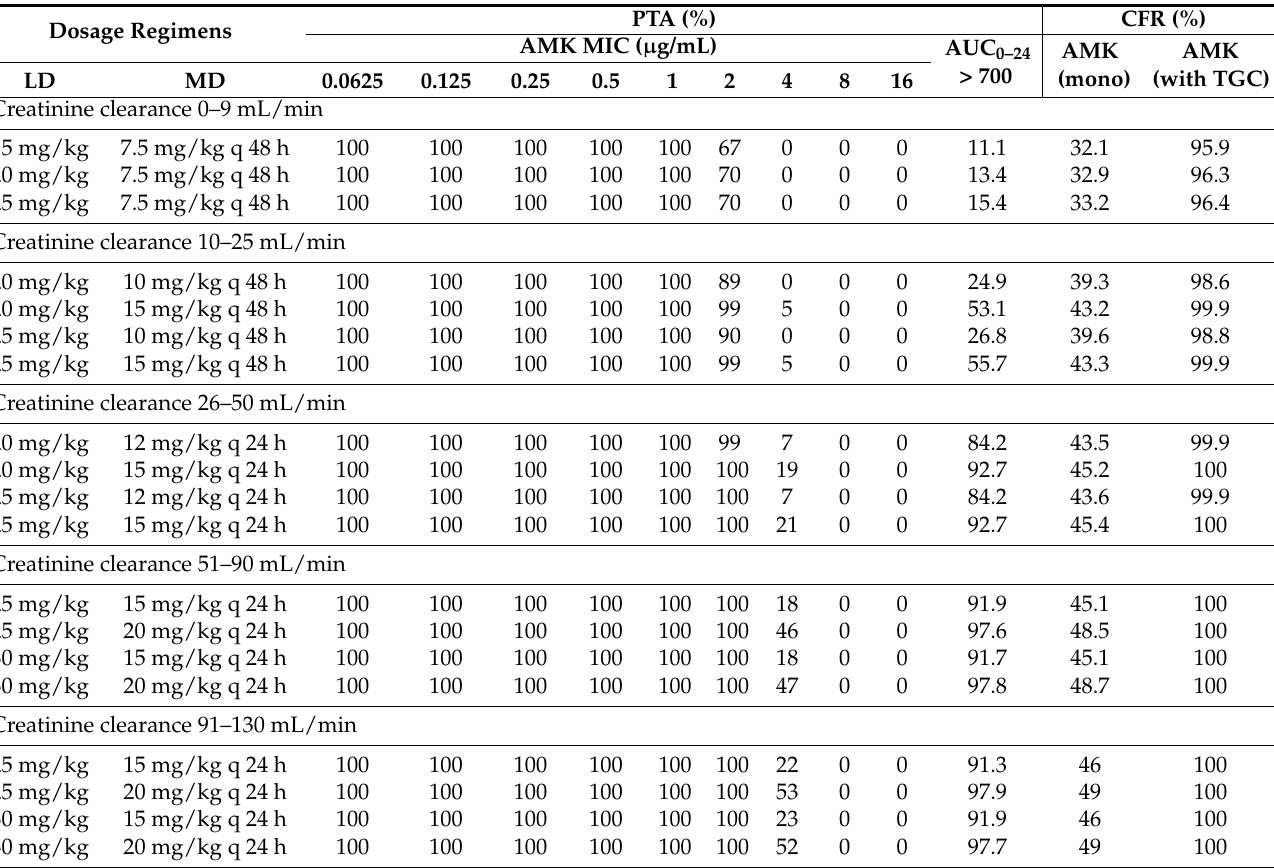
dose of 15–20 mg/kg of amikacin met the PTA target in patients with creatinine clearance levels of more than 50 mL/min. No regimens achieved the target at MIC50 and MIC90. For gentamicin, all dosage regimens met the PTA target in critically ill patients with an MIC of 0.25 (MIC50) and 0.5 µ g/mL. At a MIC of 1 µ g/mL, 4 mg/kg and 5 mg/kg once daily regimens (extended infusion) reached the PTA target in patients with creatinine clearance at 10–50 and 51–90 mL/min, respectively. No regimens achieved the target with a gentamicin MIC90 of 4 µ g/mL, nor did any regimen of aminoglycosides achieve the CFR target when used as single agents, whereas all regimens of aminoglycosides met the target when combined with other antibiotic agents. The PTA and CFR values for different aminoglycoside regimens are evaluated in Tables 5 and 6. Table 5. The PTA and cumulative fraction of response (CFR) for the different amikacin regimens in critically ill pa- tients according to kidney function (creatinine clearance) at steady state with targets of C max /MIC > 8 (for efficacy) and AUC 0–24 >